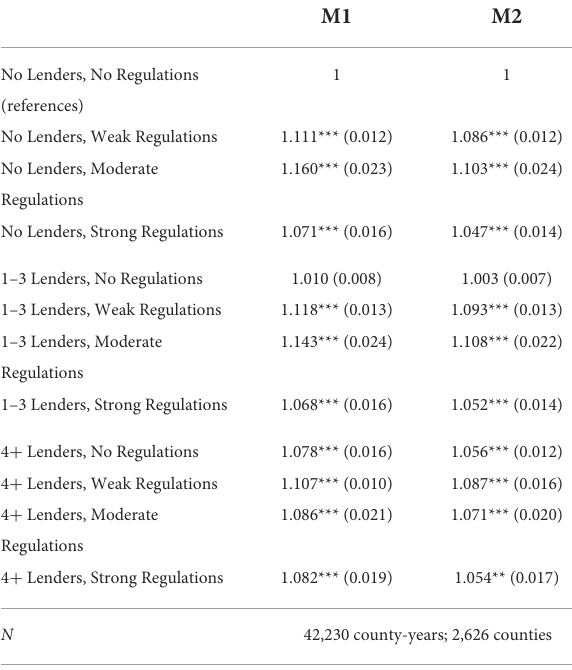
TABLE 4 Incidence risk ratios for premature deaths by lender presence and regulatory strength. M1